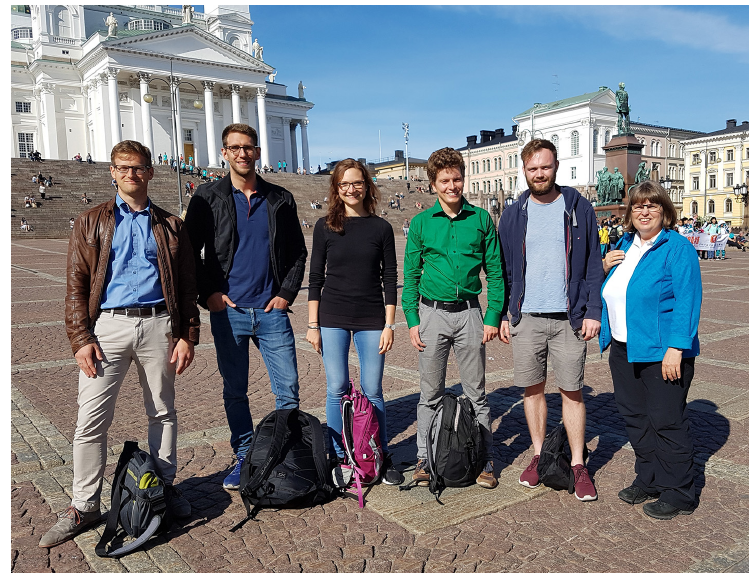
Figure 2: From left to right: Dominik Müller, Matthias Killiches, Nicole Barthel, Daniel Kraus, Alexander Kreuzer, and Claudia Czado. Photo taken in Helsinki, Finland, during the European Meeting of Statisticians held in July,